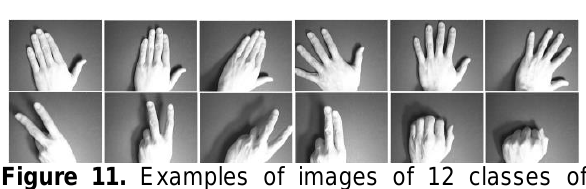
Figure 11. Examples of images of 12 classes of hand pose of dataset part 1